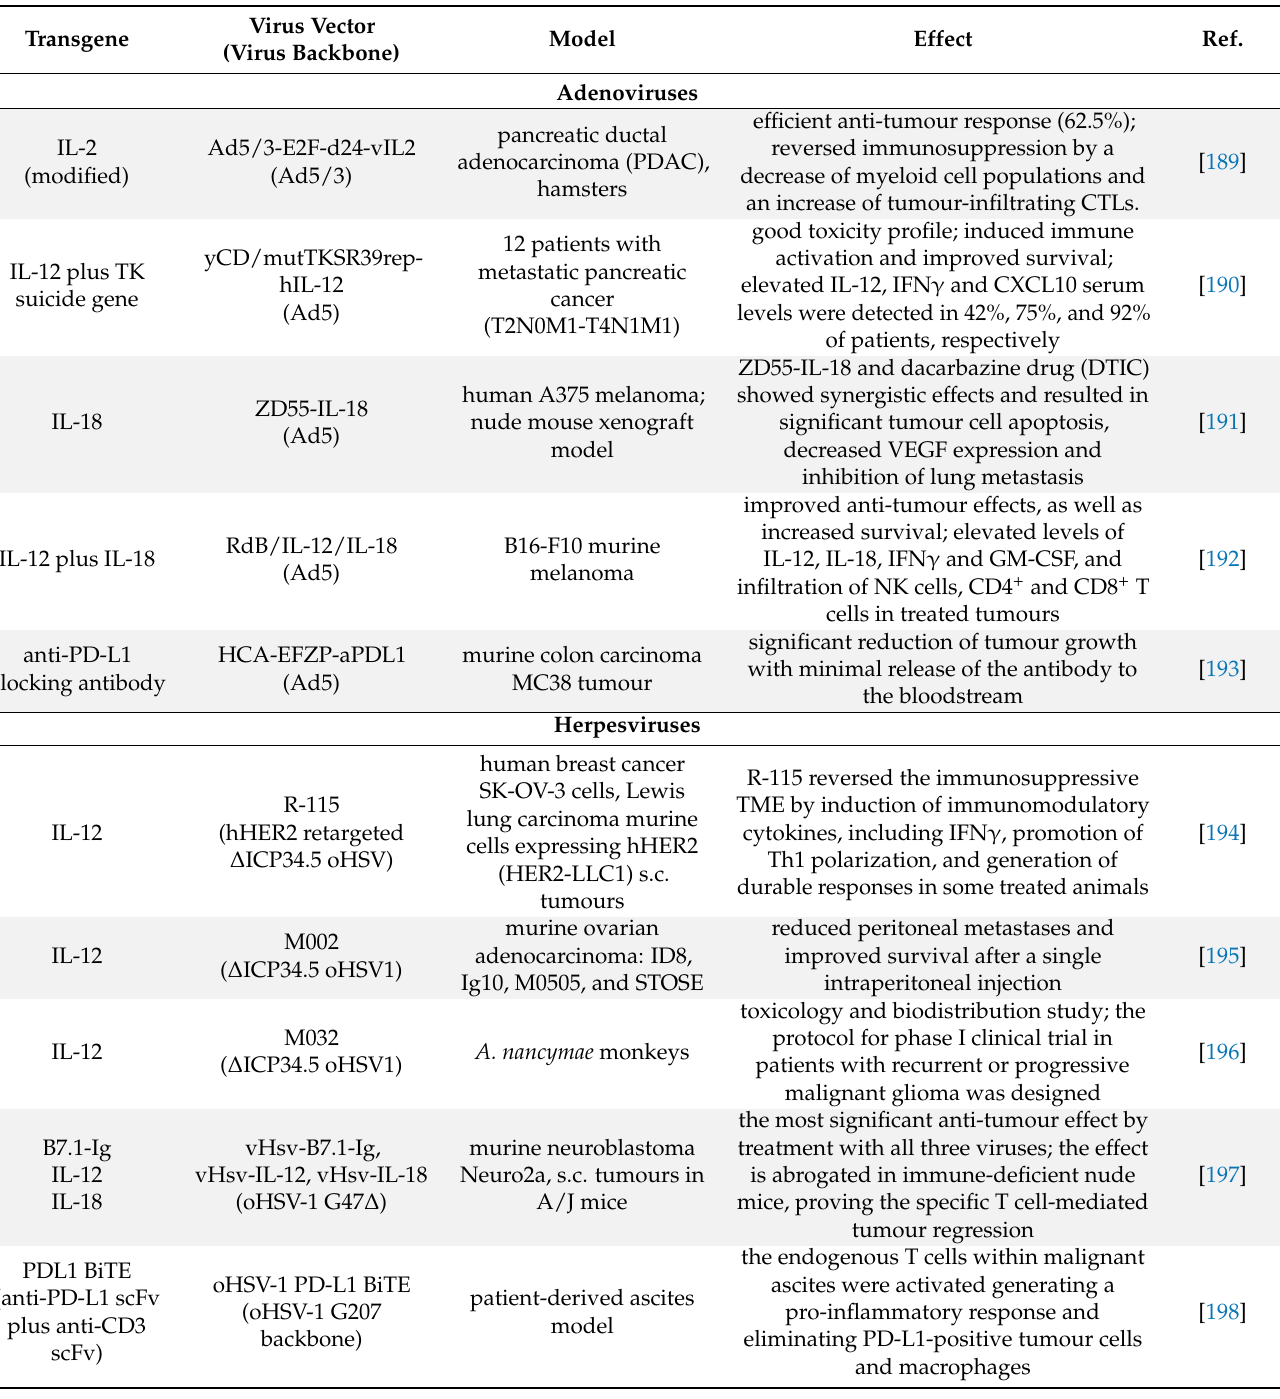
Table 3. Virus vectors encoding cytokines and other molecules activating NK and T